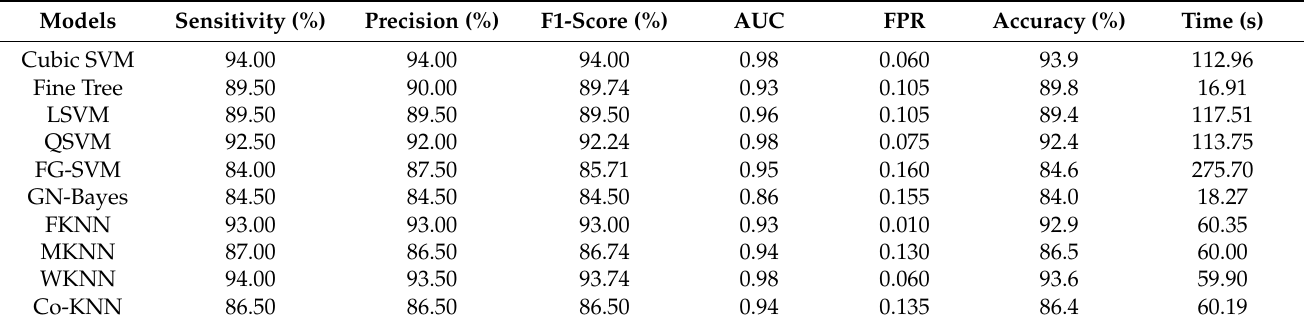
Table 3. Classification results using Fine-tuned Nasnet deep features for CBIS-DDSM.